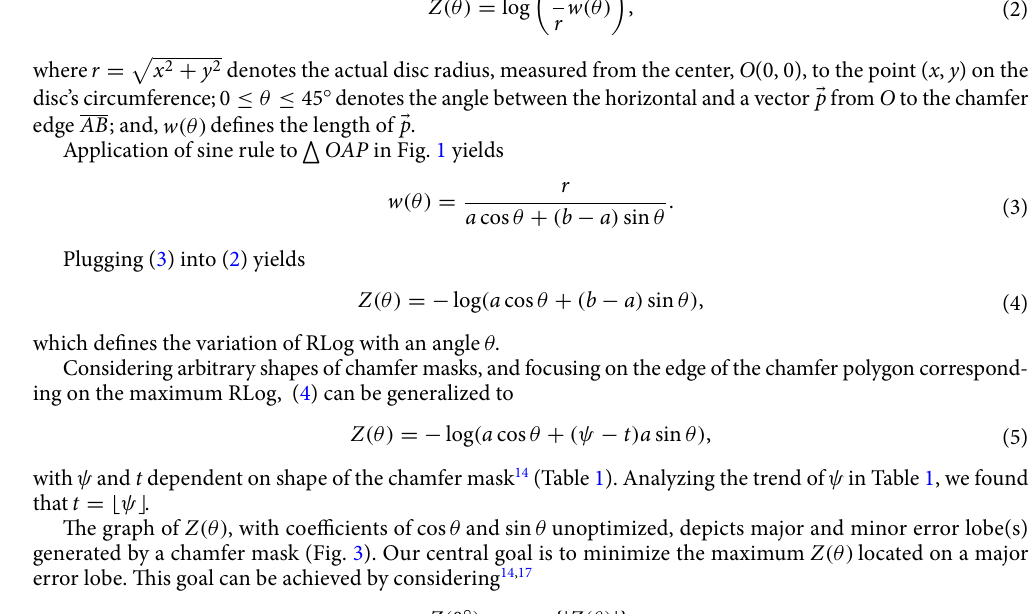
Figure 1. Octant portion of an eight-sided polygon generated by 3 A (